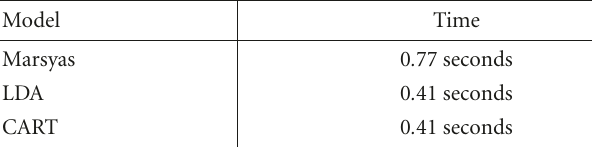
Table 7: Time required to calculate two-million